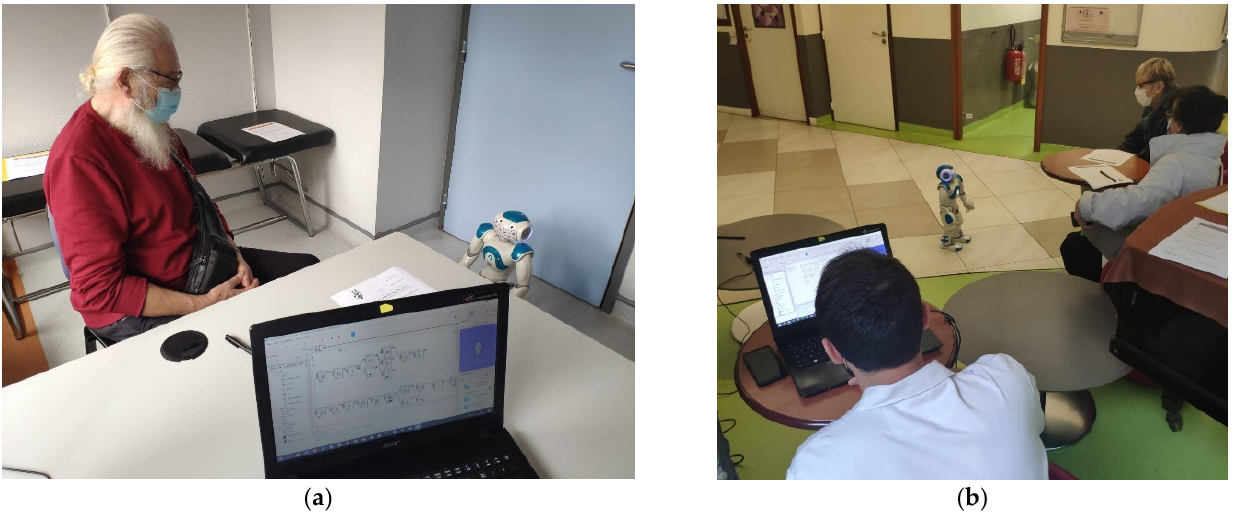
Figure 4. Robot-mediated activity for the promotion of precautionary measures: ( a ) Individual test session with a patient from the Memory Clinic of the Broca Hospital ( b ) Test session with a patient and a family caregiver at Broca Hospital.